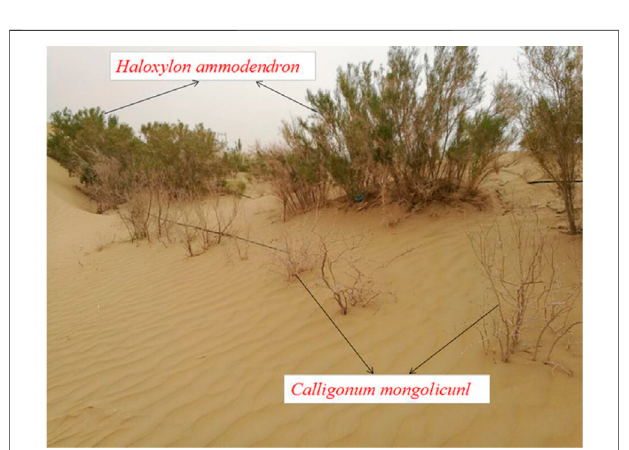
FIGURE 9 | Growth status of Haloxylon ammodendron and Calligonum mongolicunl in parts of the Taklamakan Desert Highway shelterbelt (Li et al., 2017).